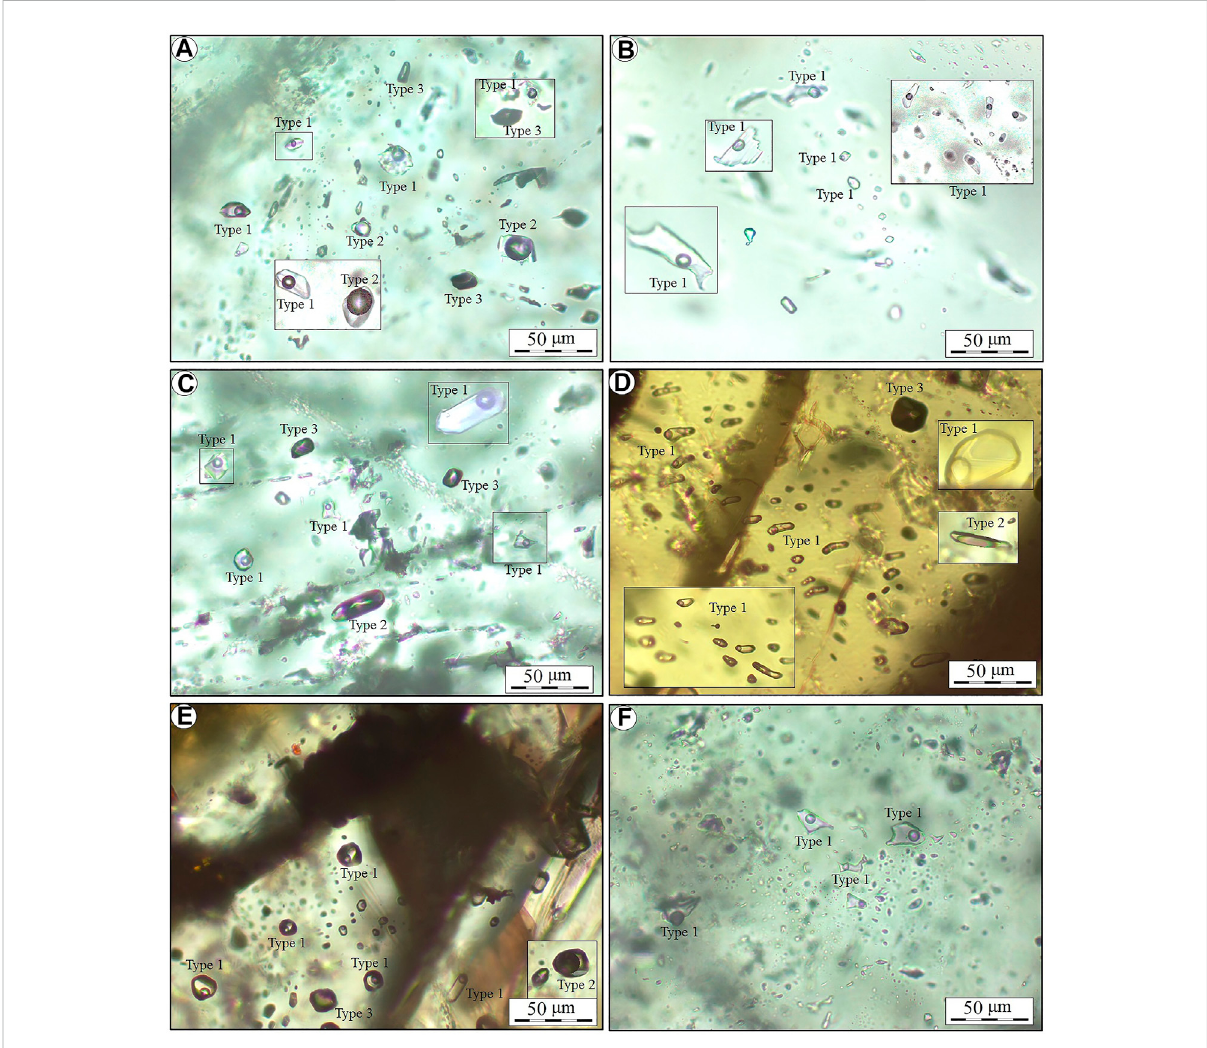
FIGURE 9 Representative photomicrographs are showing different FI types and assemblages in quartz and sphalerite from the Tashvir and Varmazyar epithermal base metal deposits. (A) . Coexistence of types 1 and 2 inclusions together with type 3 inclusions hosted by quartz from ore-stage 1 at Tashvir. (B) .Random, andscattereddistributionoftype1inclusions hostedbyquartzfromore-stage2atTashvir.C ‒ E.Assemblages oftypes1,2, and 3 FIs hosted by quartz (C) and sphalerite (D,E) from ore-stage 2 at Varmazyar. (F) . Type 1 inclusions within quartz of ore-stage 3 at Varmazyar. Note that FIs enclosed in the rectangles are from different depths and are brought to focus as